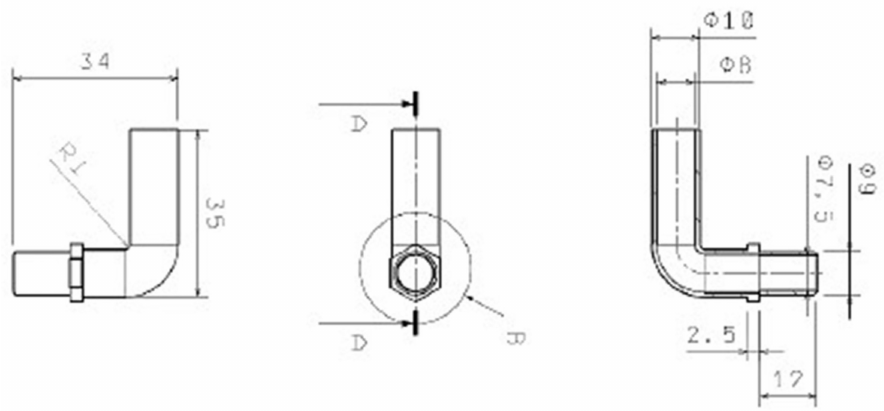
Figure 6. The exact geometry of the tube prototype used for the entry of the working medium into the cylinder